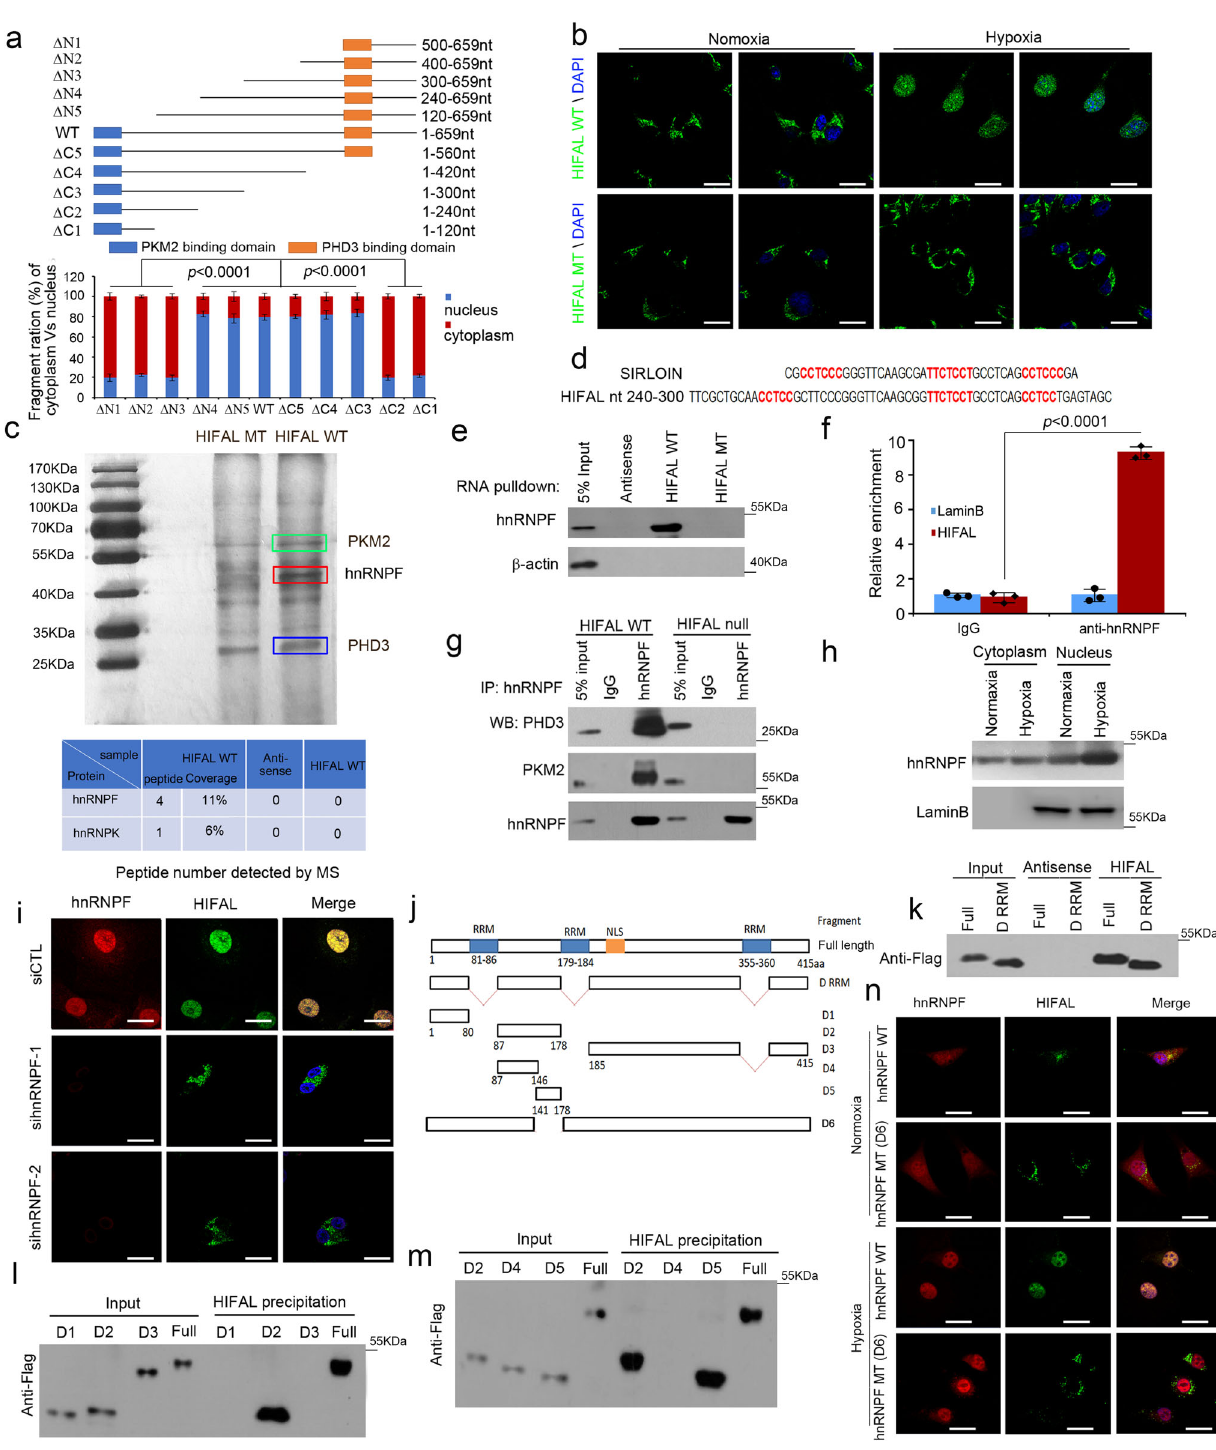
mediated feed-forward loop of HIF-1 α transactivation. Mean- while, a series of PKM2 mutants were generated to investigate the effect of prolyl hydroxylation of PKM2 on HIFAL-mediated HIF- 1 α transactivation. The overexpression of Pro408Ala or Pro403/ 408Ala mutants could not increase the HIFAL-mediated HIF1 α transactivation, whereas Pro403Ala mutant, as well as WT PKM, could do so with similar ef fi ciency. These results suggested that the prolyl hydroxylation of Pro408 in PKM2 was essential for the HIFAL-mediated HIF1 α transactivation (Supplementary Fig.